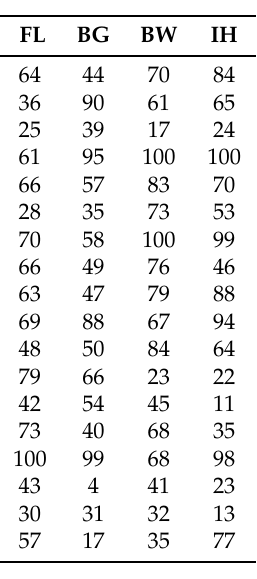
Table 1. Percentile profiles of outliers of foot shape variables for women.